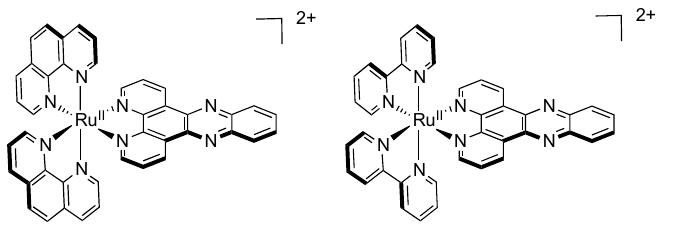
(DPPZ)] 2+ (left) and [Ru(bpy) 2